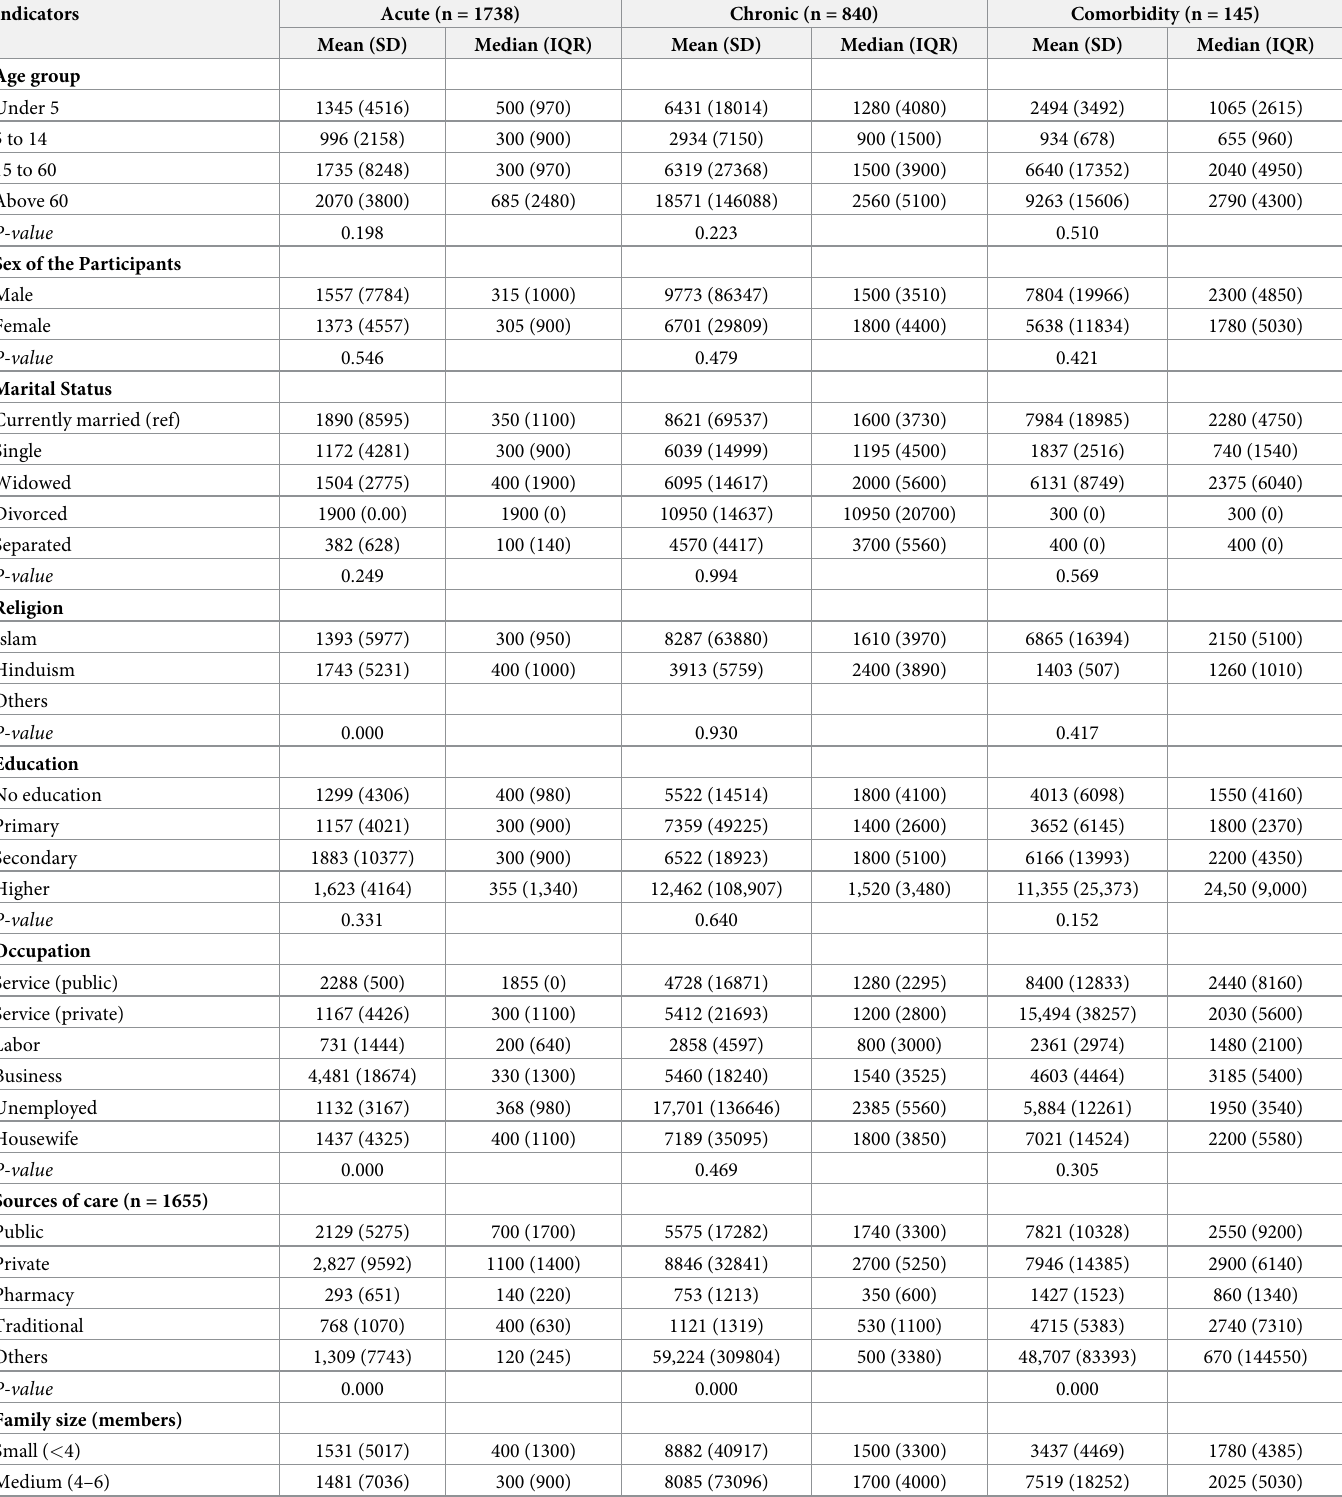
Table 3. Distribution of OOP cost across